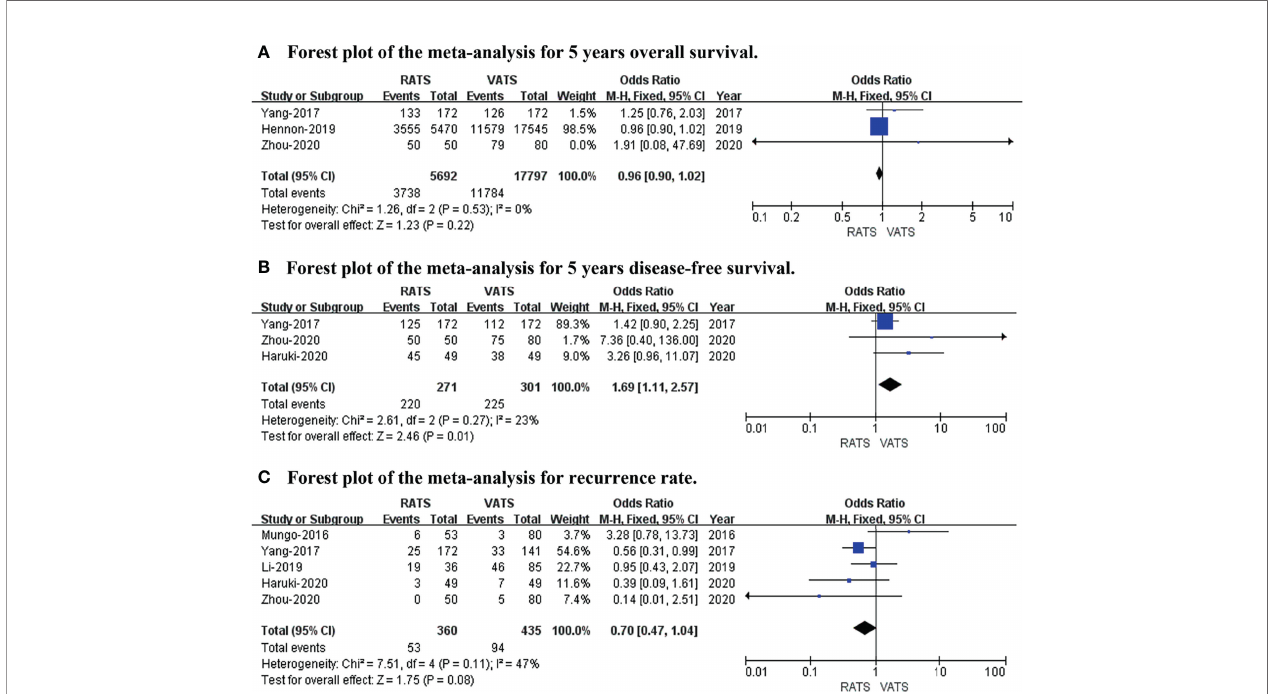
FIGURE 5 | Forest plot of the meta-analysis for long − term oncological outcomes. (A) Forest plot of the meta-analysis for 5-year overall survival. (B) Forest plot of the meta-analysis for 5-year disease-free survival. (C) Forest plot of the meta-analysis for recurrence rate.